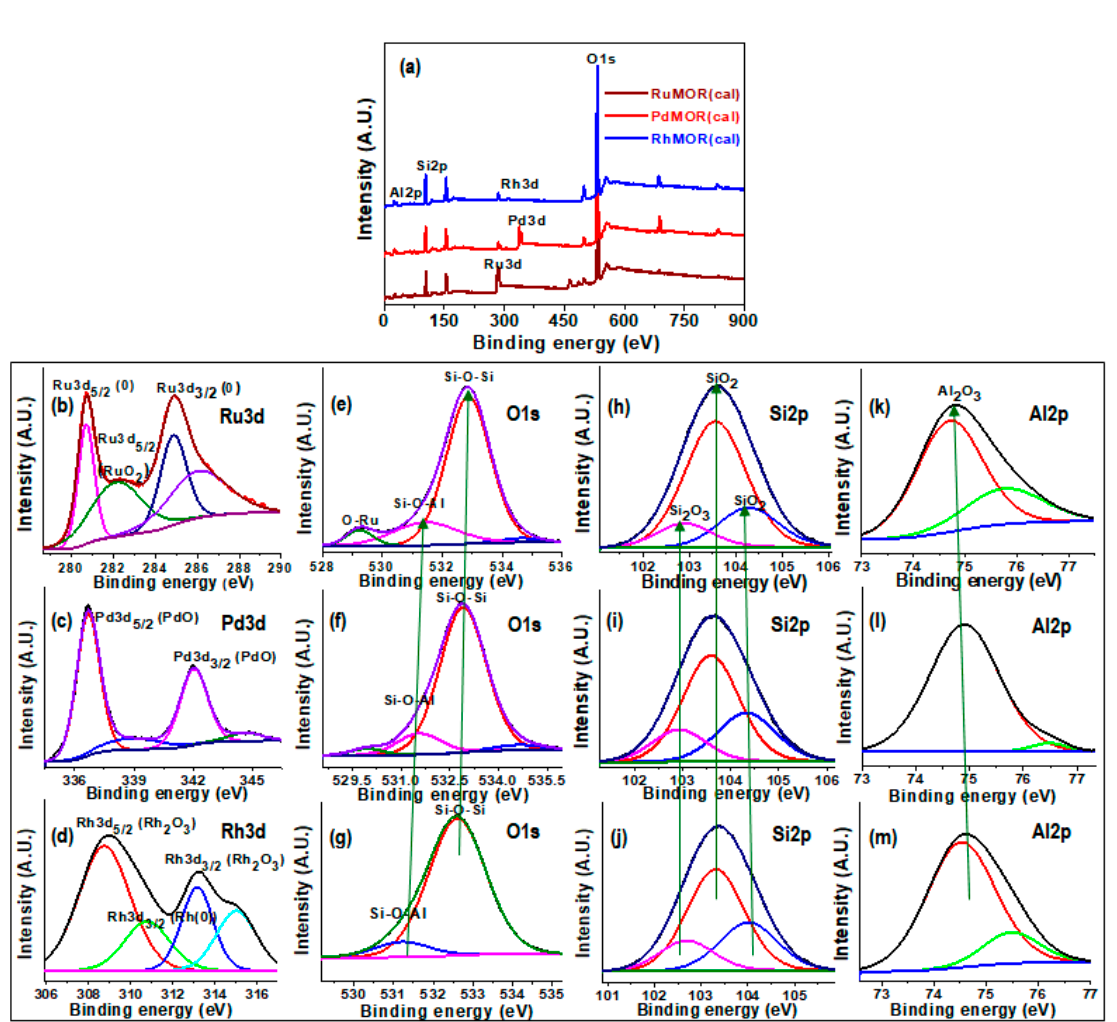
Figure 3. ( a ) Full scan survey X-ray photoelectron spectroscopy (XPS) spectra of calcined